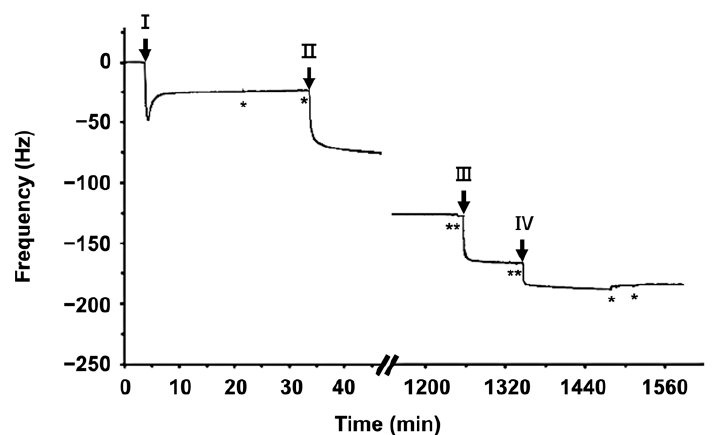
Figure 2. Surface modification and the non-fouling effect monitored by QCM-D. The kinetics of the stepwise formation of the surface coating, monitored by normalized frequency F using QCM-D for the coating with mEpCAM antigens. Lipid vesicles containing 4 mol% of b-PE were introduced at point (I) and absorbed and ruptured to form bSLB on a silicon dioxide chip. NeutrAvidin (NA) solution was injected at point (II) and incubated for 20 h for specific binding on SLB, forming NA-bSLB. Biotinylated anti-mEpCAM IgG solution was added at point (III) to conjugate anti-mEpCAM to the NA-bSLB layer. Then, recombinant mEpCAM was injected at point (IV) to determine the IgG-antigen binding ratio. The pH 7.2 PBS buffer rinse, denoted as *, was performed at least once after each step.